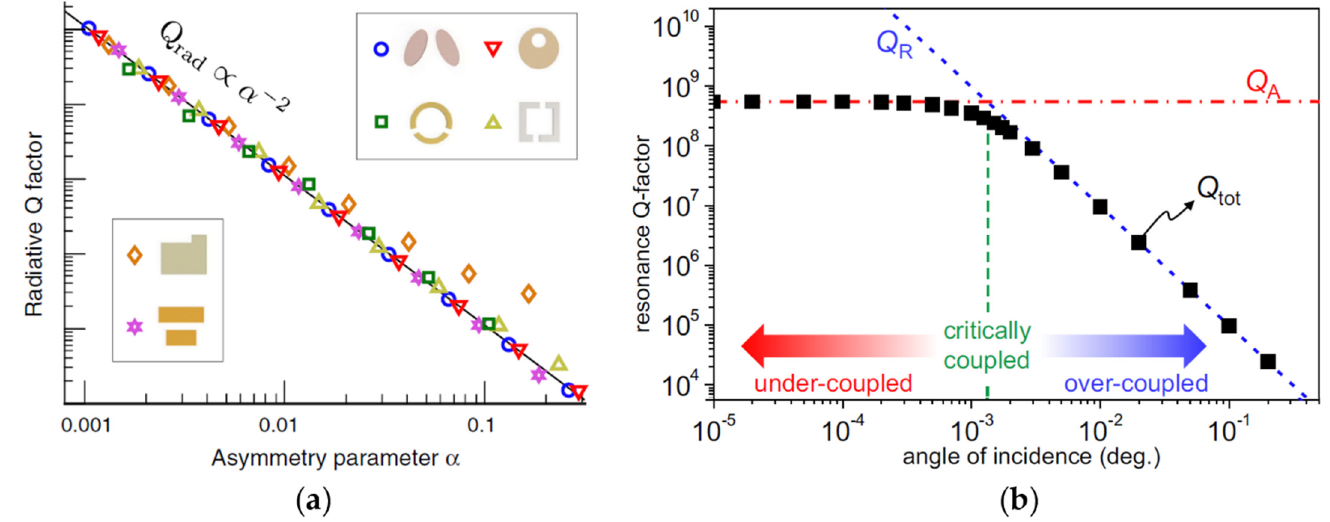
Figure 2. Characteristics of Q values of quasi-BICs. ( a ) The relationship between the radiation factor Q R and the asymmetry parameter α in symmetry-broken metasurfaces (reprinted with permission from [44], ©2018, APS); ( b ) the relationships between Q tot , Q R , and Q A . When Q R tends to infinity, Q tot is still limited by Q A (reprinted with permission from [36], ©2015, Jae Woong Yoon et al., CC BY license).